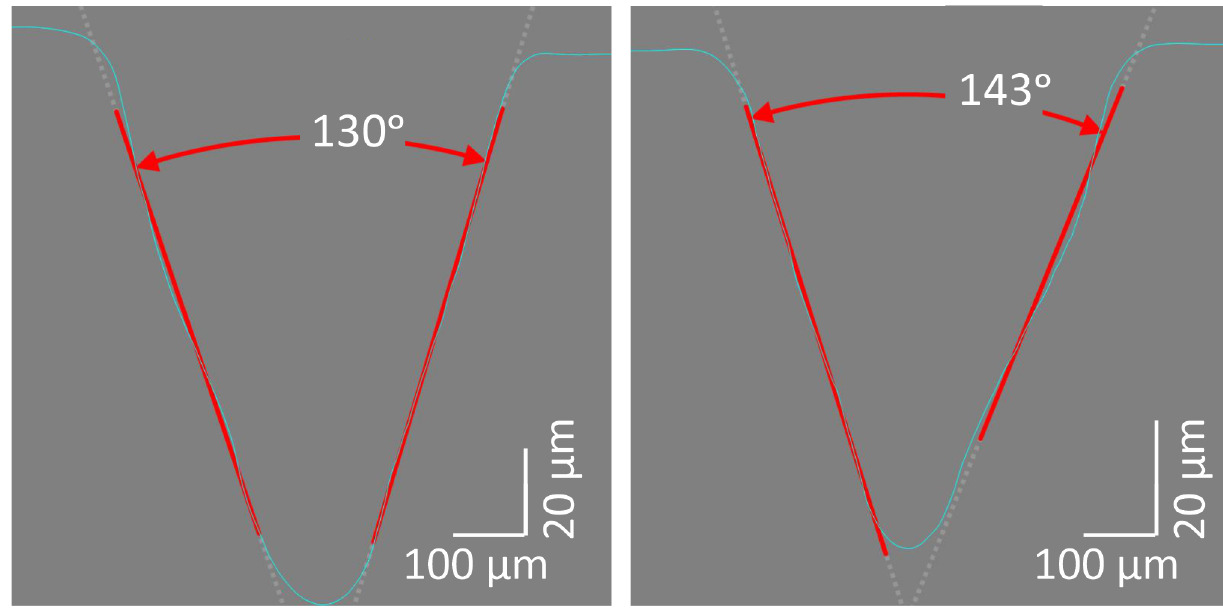
Figure 13. Example of V-shaped grooves. F = 38.1 mm, P = 25 W. ( left ): S = 120 mm/s desired pitch angle; ( right ): S = 60 mm/s undesired pitch